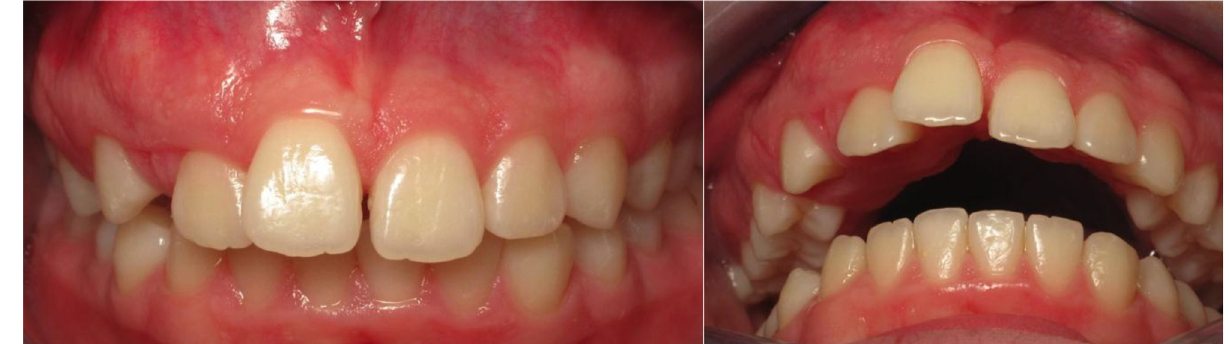
Fig. 1. Gingival vestibular and palatal tumor located between the maxillary right lateral incisor and the right maxillary canine with a homogeneous rosy mucosa, without ulceration.